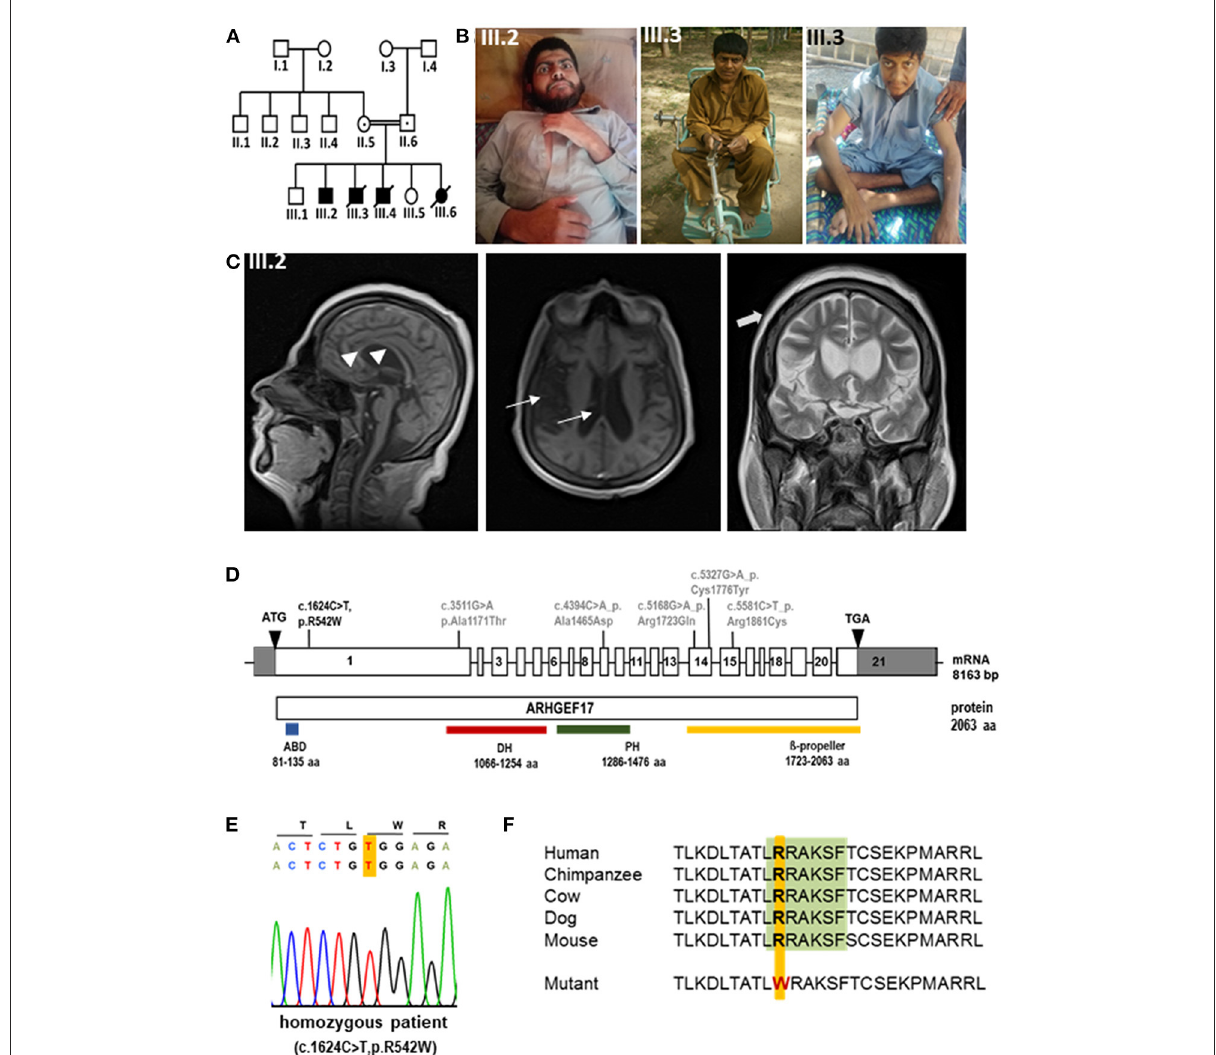
FIGURE1 Phenotype and genotype of index patients with ARHGEF17 mutation (A) Pedigree of index family indicating affected patients (III.2, III.3). (B) Photomicrographs of III.2 and III.3. (C) MRI images of III.2 revealed general atrophy/hypoplasia of the brain parenchyma, enlarged ventricular system (thin arrows) and thin, but complete corpus callosum (arrow heads), chronic ischemic changes periventricular white matter surrounding occipital horns, moderate cerebral atrophy and thickened scull bone (thick arrows). (D) Schematic representation of ARHGEF17 cDNA with 21 exons and the wild-type ARHGEF17 protein with the identified variants of our index family (black) and previously reported homozygous variants (gray). A homozygous exchange of a single base C to T in exon 1 of the ARHGEF17 (c.1624C > T (NM_014786.4), p.R542W (NP_055601.2) was identified and confirmed through Sanger sequencing. (E) Electropherogram traces depicting the exchange of C to T at position 1624 of the ARHGEF17 gene. (F) The site of mutation is located in DCLK1 consensus site [LRRAKSF (green)] of ARHGEF17 and it is highly conserved across